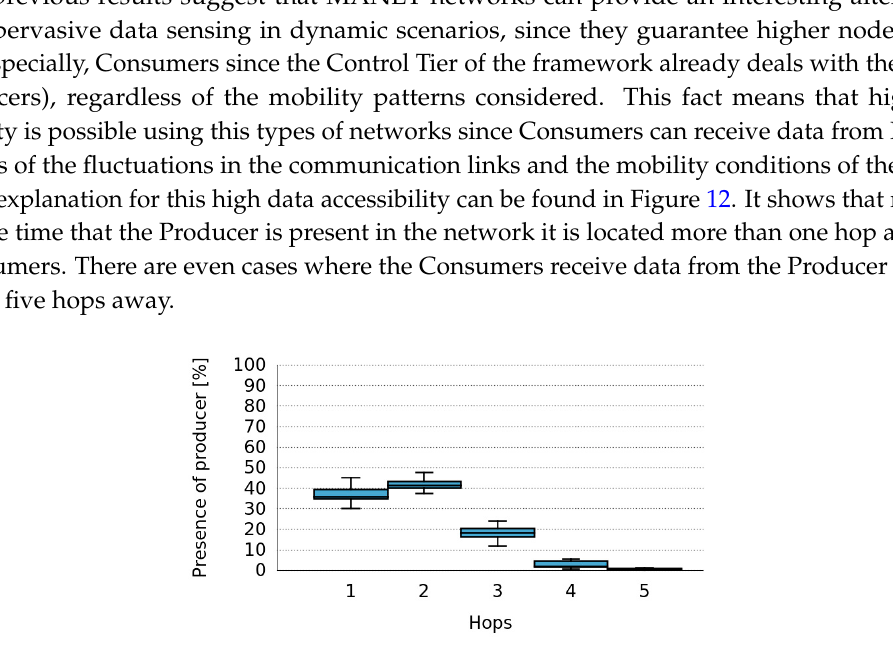
Figure 12. Percentage of presence of the Producer versus the number of hops in MANET networks.